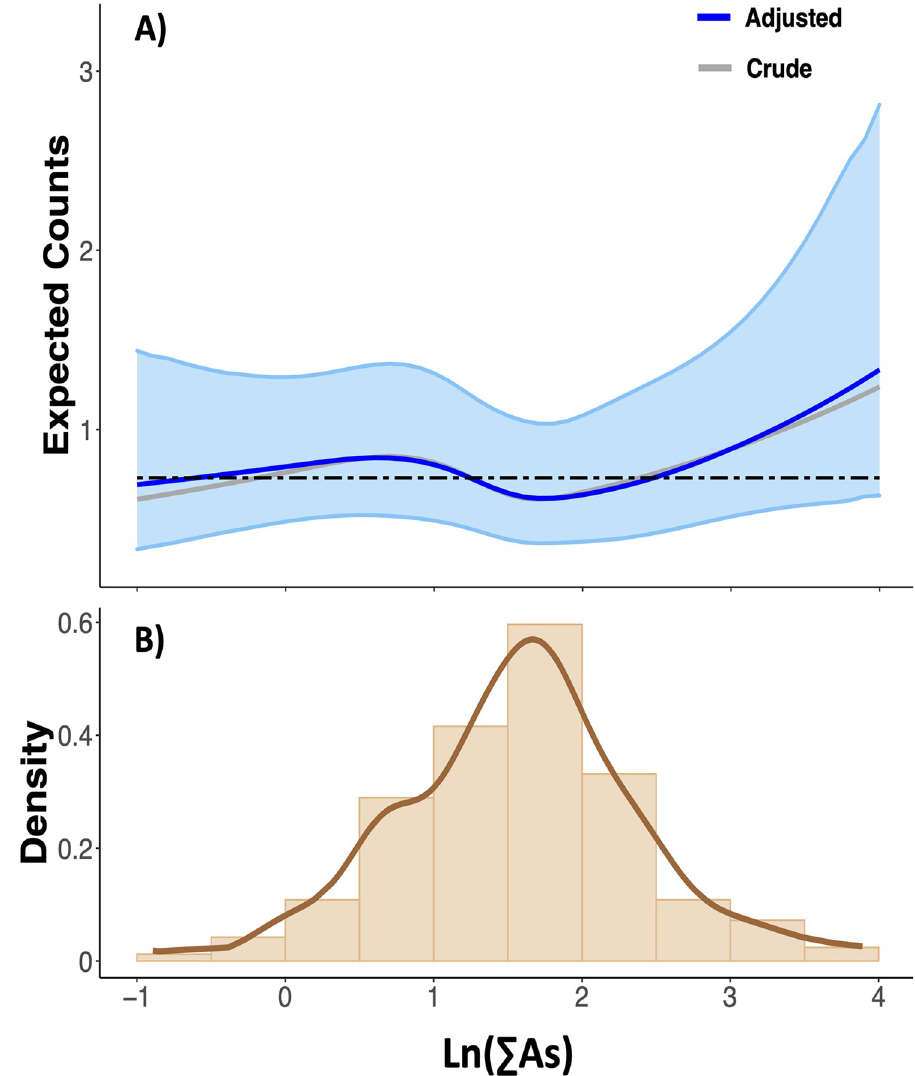
Fig 1. Generalized Estimating Equation (GEE)—Poisson regression spline function between natural ln- transformed urinary arsenic concentrations ( ∑ As) and expected respiratory symptoms at 4 and 7 years of age. The ∑ As is in μ g/L. Case-complete approach (i.e., participants with missing values in the dependent, independent, or adjustment variables were not included in the analysis). N at 4 years of age equal to 339 including 0 counts = 216 (63.7%), 1 count = 73 (21.6%), and � 2 counts = 50 (14.7%). N at 7 years of age equal to 339 including 0 counts = 170 (50.1%), 1 count = 101 (29.8%), and � 2 counts = 68 (20.1%). ∑ As = iAs + MMA + DMA adjusted for specific gravity. Fig. A ) Generalized Estimating Equation (GEE) using family equal Poisson and splines functions. Respiratory symptoms include asthma, asthma medication, wheeze, wheeze medication, sneeze, and eczema. The grey line shows the crude model. The dark blue line shows the adjusted models for child sex (boys or girls), and maternal smoking status (“Have you ever smoked?”—binary) and level of education (primary, secondary, or university studies), cohort (Asturias, Gipuzkoa, Sabadell, or Valencia), and calorie adjusted consumption of vegetables (g/day), fruits (g/day) and fish/seafood (g/day) at 4 and 7 years of age. The blue shade shows the 95% confidence interval of the adjusted model. The black dashed line shows the average expected counts (0.73). To facilitate interpretation, the crude and adjusted estimates (95% confidence intervals) at ln-transformed urinary ∑ As 1.57 (average concentration), and 4.00 (99 th percentile concentration) were 0.62 (0.48, 0.80)– 0.63 (0.36, 1.10) and 1.24 (0.63, 2.42)– 1.33 (0.61, 2.89), respectively. Fig. B ) Density function of ln-transformed ∑